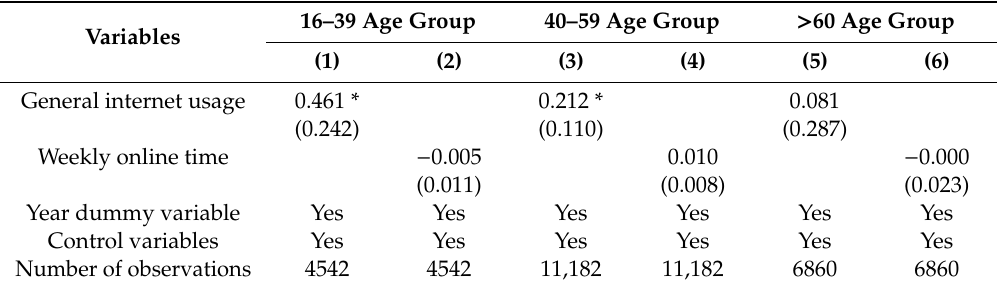
Table 5. Impact of internet use on health outcomes in di ff erent age groups.